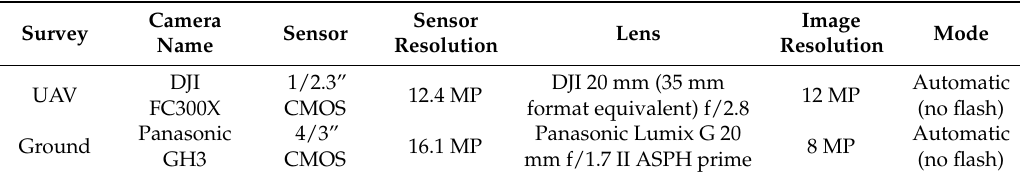
Table 1. Camera specifications.